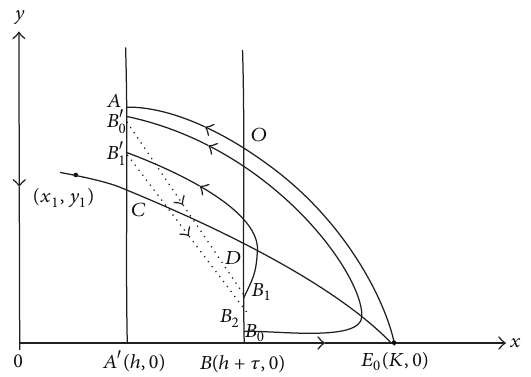
Figure 2: Existence of order one periodic solution of (2).